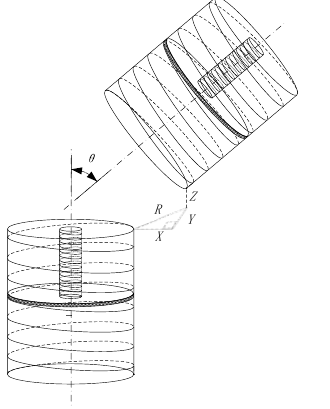
Figure 5. Schematic diagram of double mutual inductance voltage method.